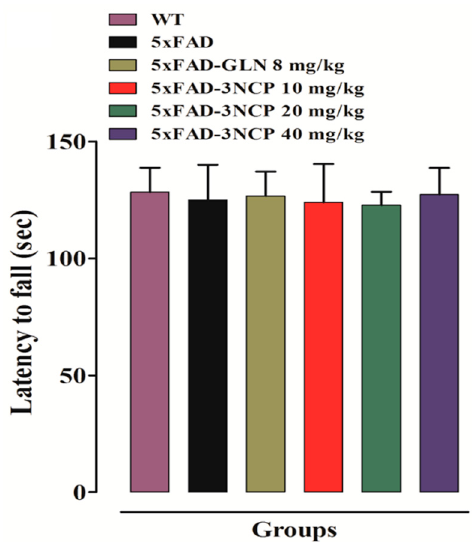
Figure 3. The effect of 3NCP on balance and motor coordination in the rotarod test. Bars represent mean ± SEM. Data was analyzed with one-way ANOVA followed by Dunnett post hoc test ( n = 10 mice/group).